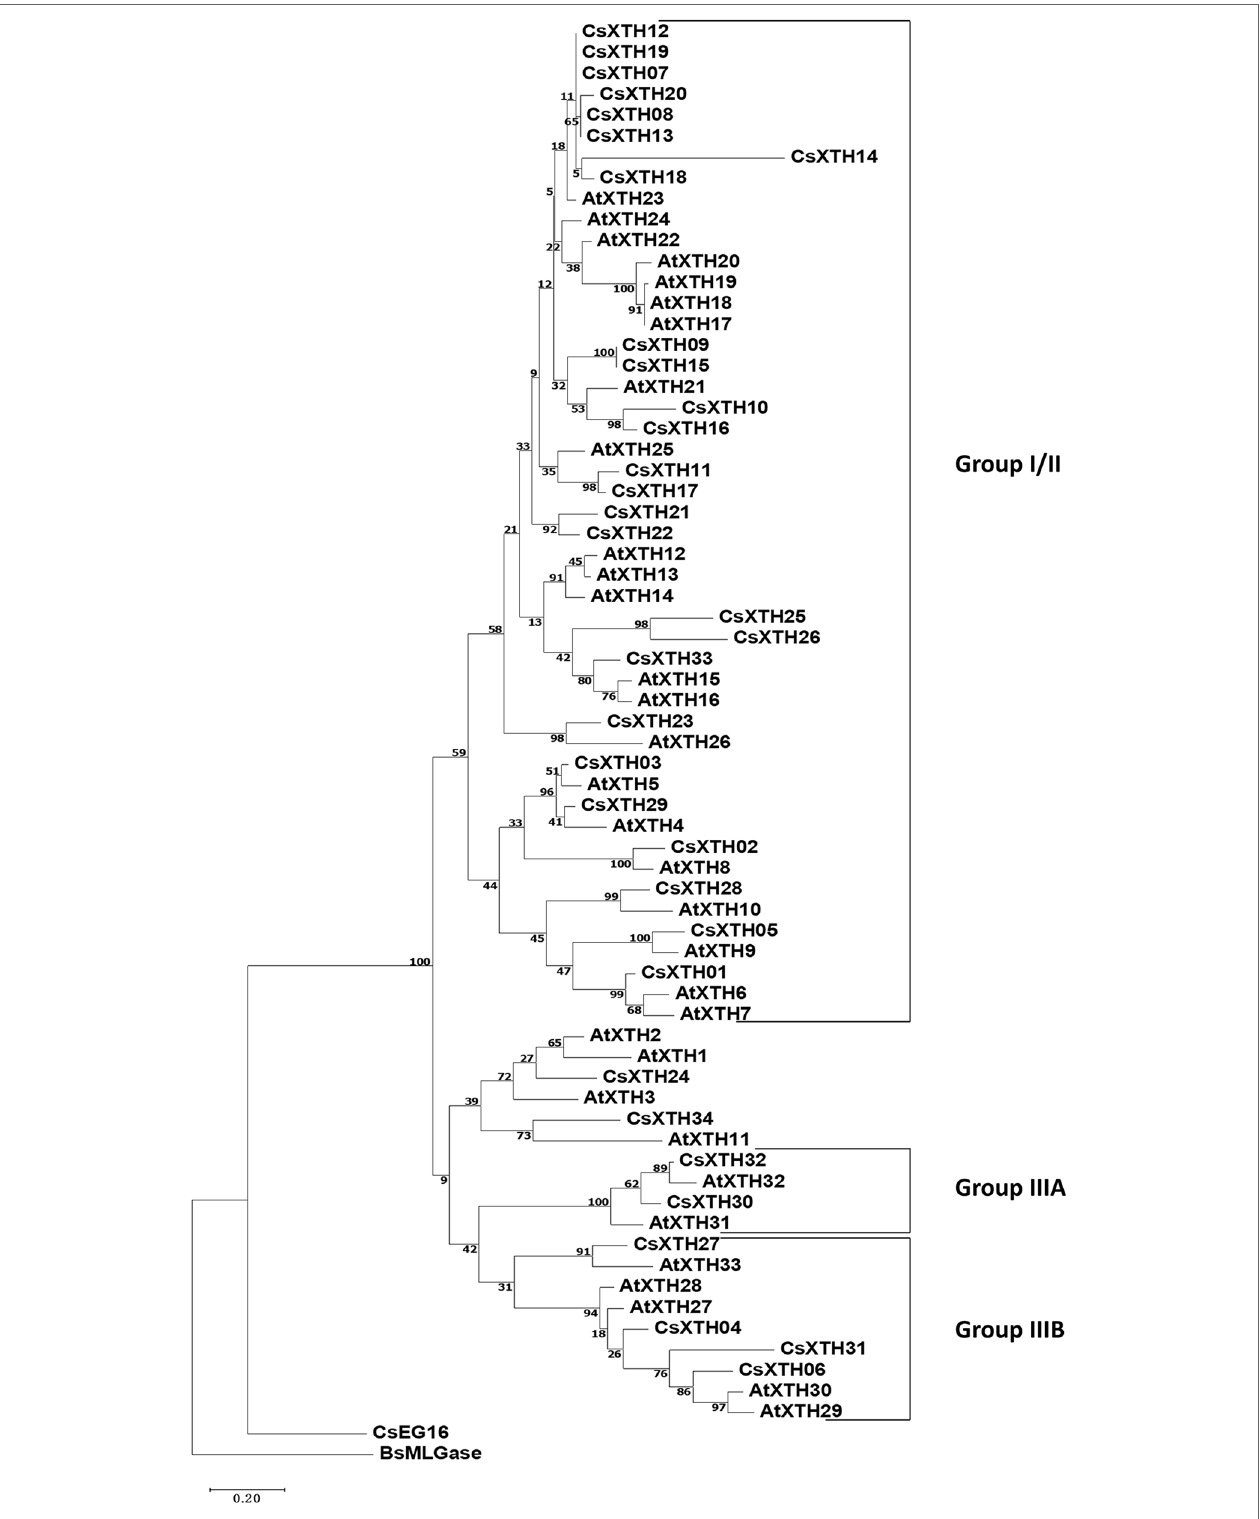
FIGURE 1 | Rooted maximum-likelihood (ML) phylogeny of XTHs and EG16 from sweet orange and Arabidopsis thaliana . All complete XTHs and EG16s from A. thaliana and sweet orange were used for ML tree construction using MEGA 7 with bootstrap = 500. Sub-family assignments are indicated on the right. Trees were rooted by BsMLGase. XTH, xyloglucan